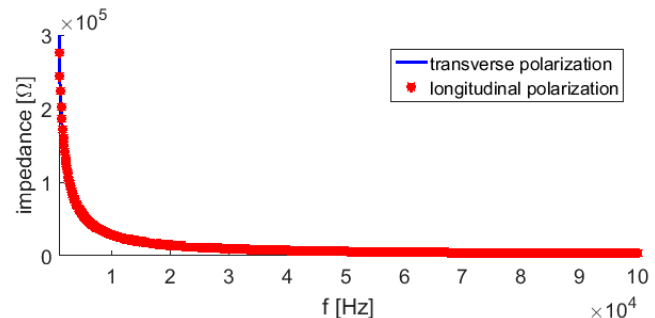
Figure 8. Frequency response of the piezoelectric transducers used during the tests.